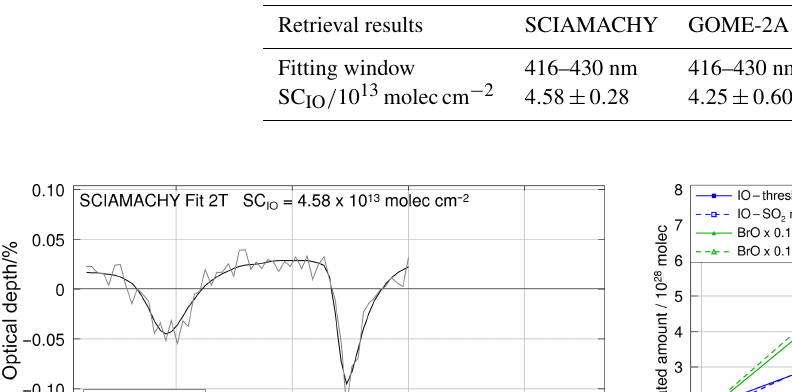
Table 2. IO retrieval results from the collocation case between SCIAMACHY and GOME-2A on 11 August 2008. The three results agree within their fitting errors.